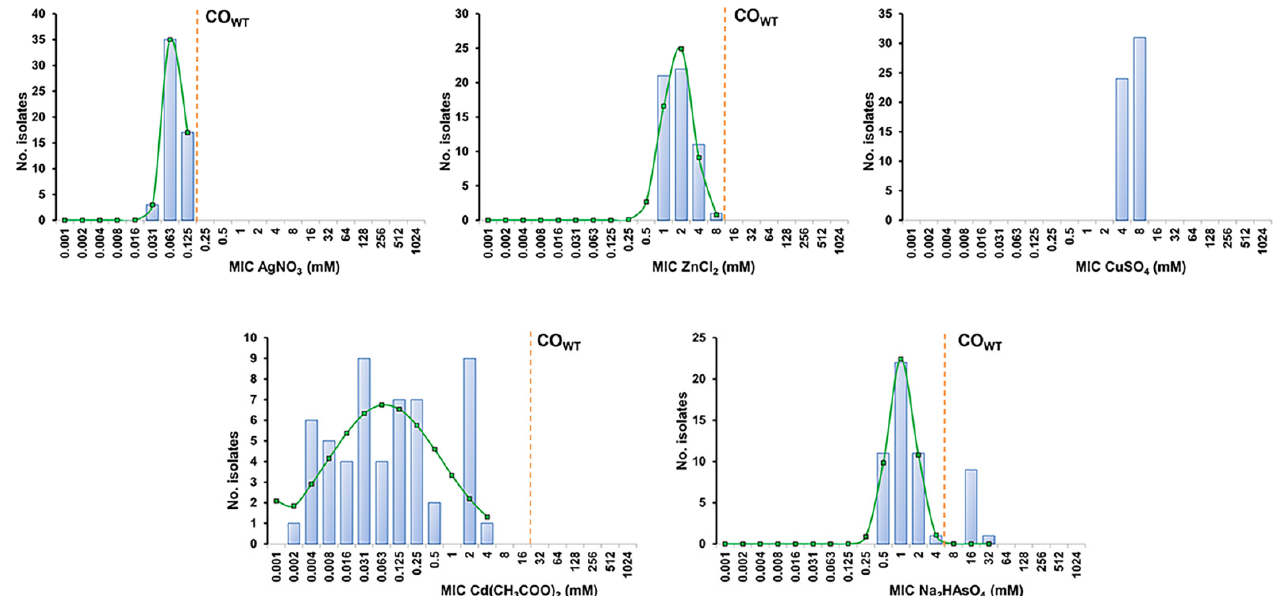
Figure 1. MIC distributions and estimation of cut-off (CO WT ) values of the 55 SSTI-related S. aureus from companion animals for the heavy metals silver nitrate (AgNO 3 ), zinc chloride (ZnCl 2 ), copper sulphate (CuSO 4 ), cadmium acetate (Cd(CH 3 COO) 2 ) and disodium hydrogen arsenate (Na 2 HASO 4 ). The CO WT values were estimated with the iterative statistical method using the ECOFFinder datasheet available at https://www.eucast.org/mic_distributions_and_ecoffs/ (accessed on 10 November 2021). The blue columns represent the MIC values determined for all isolates, whereas the green line indicates the distribution of MICs for the wild-type (WT) population estimated by the ECOFFinder. The dashed orange line indicates the CO WT value that corresponds to the highest MIC value of the estimated WT